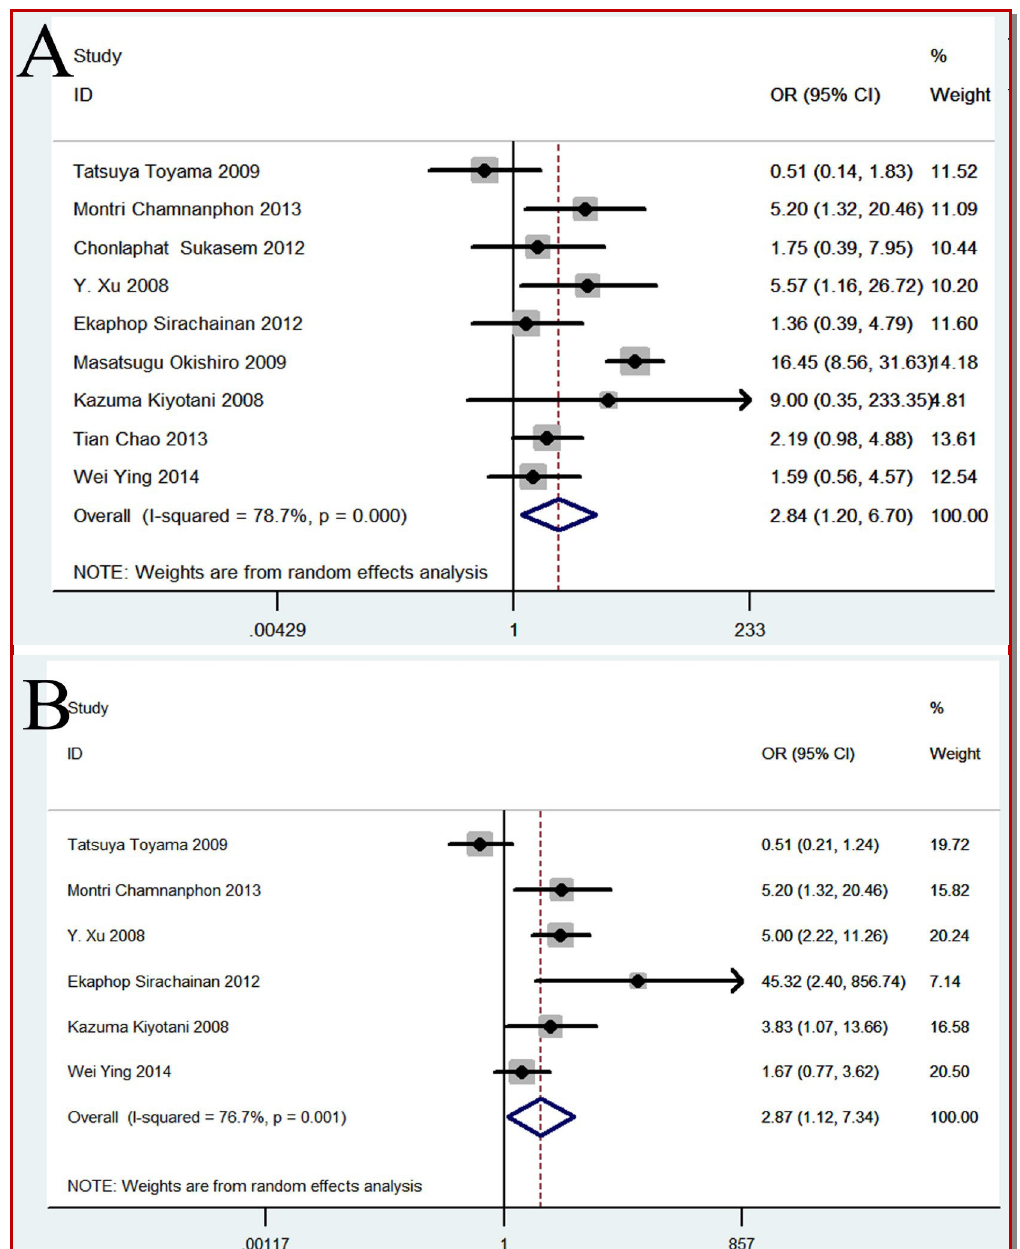
Figure 2: Meta-analysis for DFS of CYP2D6 Wt/Wt+Wt/*10 vs *10/*10. (A): 5 years-DFS; (B): 10 DFS of CYP2D6*10 wild-type homozygous vs CYP2D6*10